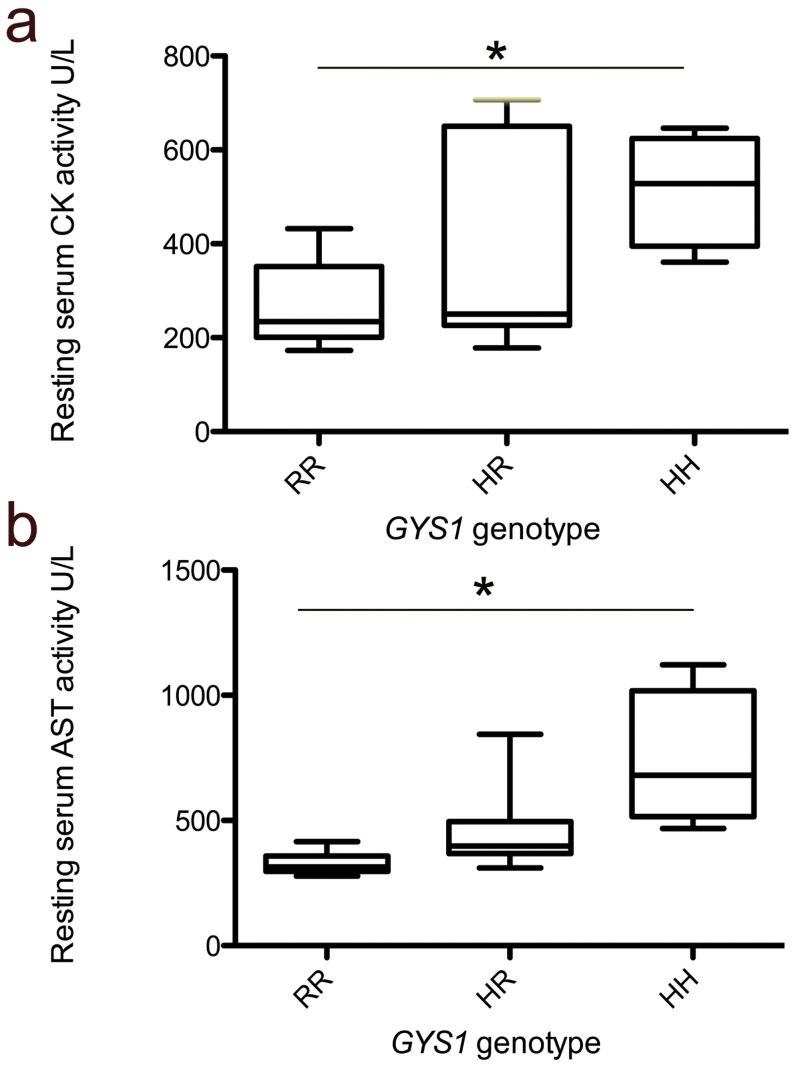
Resting muscle enzyme activities.Box plots illustrating the resting (a) CK activity and (b) AST activity for each GYS1 genotype (n = 8) (HH = homozygotes, HR = heterozygote, RR = control) * Denotes significant differences between individual groups (p<0.05) following post- hoc analysis.